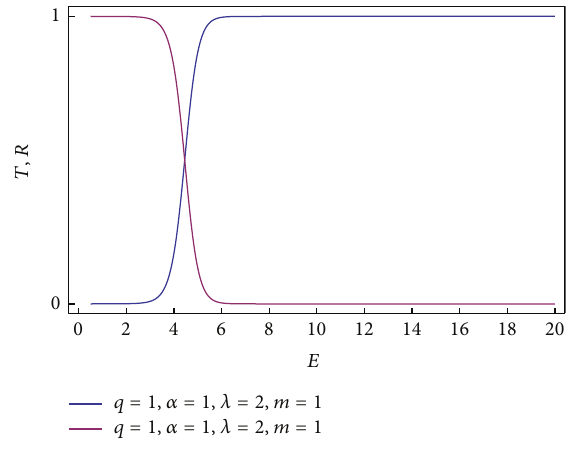
Figure 2: Unitarity condition, 𝑅 + 𝑇 = 1 .